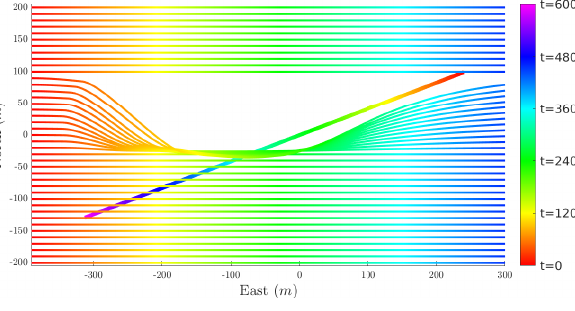
Figure 13: Batch 5: